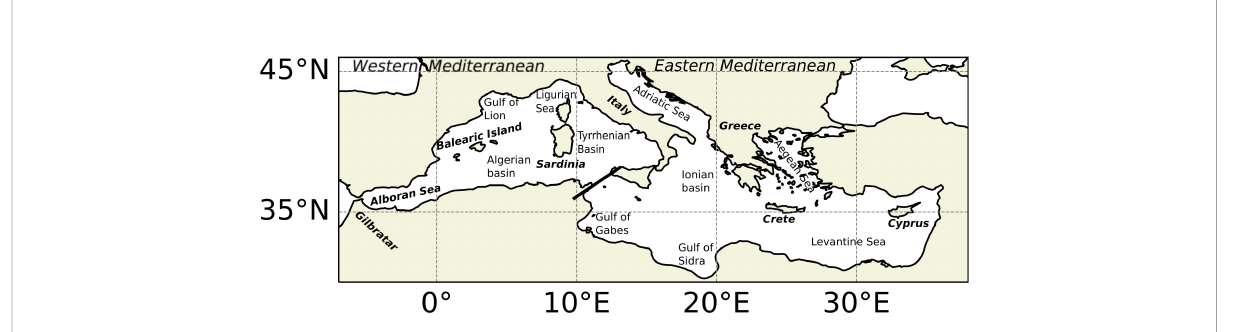
FIGURE 1 Map of the Mediterranean basin. The thick black line represents the separation between western and eastern Mediterranean